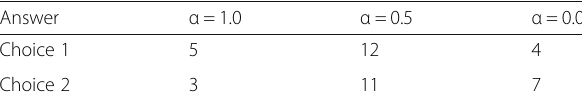
Table 4 Total number of answers of participants for choices 1 and